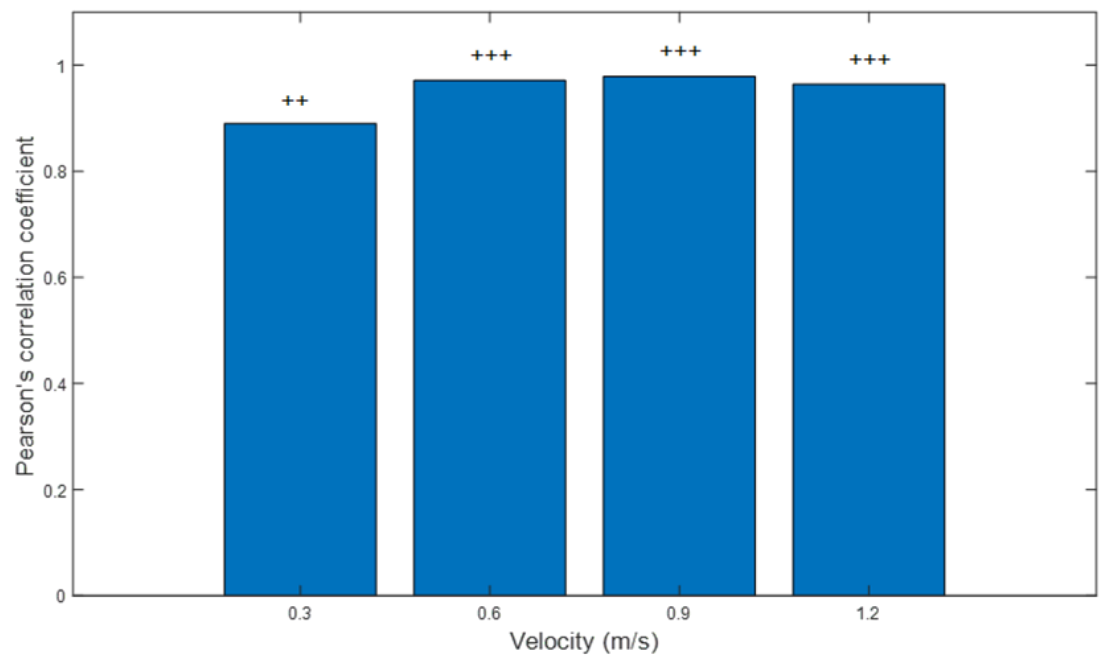
Figure 6. Single measure intraclass correlation coefficients (ICC) between the number of right limb EMG peaks of the medial gastrocnemius detected by mTrigger and DELSYS at different speeds for overground walking with 95% confidence interval. All correlations were significant at p < 0.05. Agreement: * = moderate, ** = good.